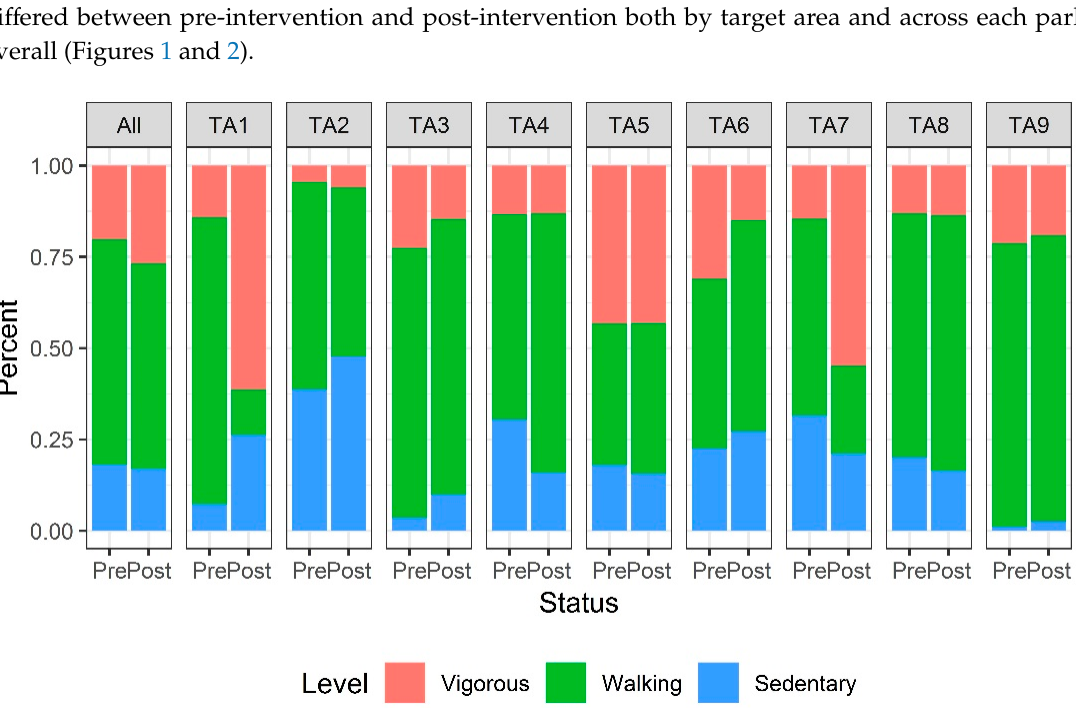
Table 1. Demographic characteristics of Park Users, pre- and post-intervention.